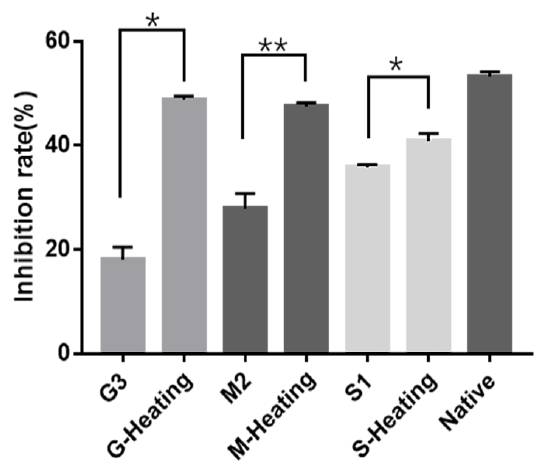
Figure 4. The inhibition of native parvalbumin and glycated parvalbumin heated by a microwave or an induction cooker. G3 (Glucose,1.5 mol/L,15 min), M2 (Maltose,1 mol/L,15 min) and S1 (Sucrose, 0.5 mol/L, 15 min) were heated by a microwave; G-Heating (Glucose, 1.5 mol/L, 15 min), M-Heating (Maltose, 1.5 mol/L, 15 min) and S-Heating (Sucrose, 1.5 mol/L, 15 min) were heated by an induction cooker. Native was unheated parvalbumin. * means ( p < 0.05) or ** means ( p < 0.01).